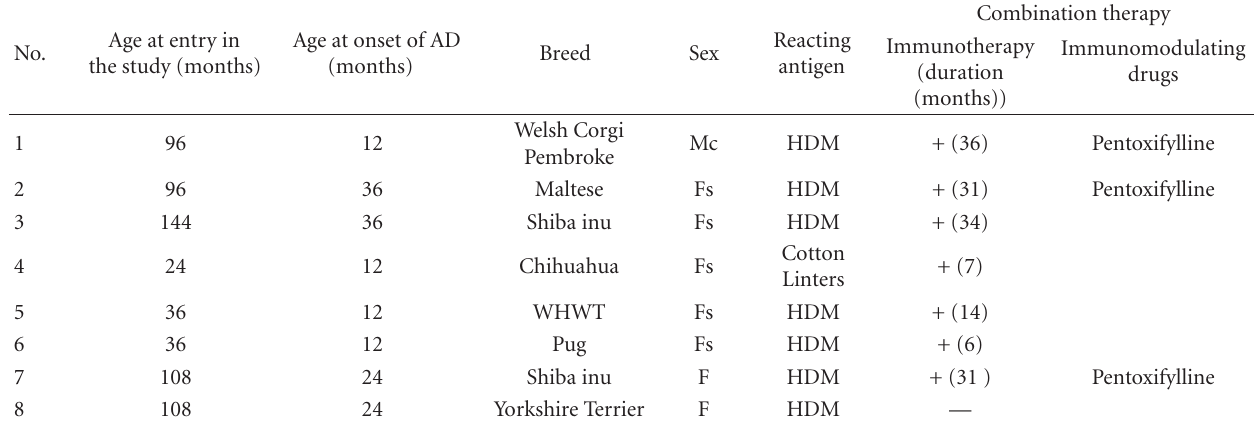
Table 1: Characteristics of dogs at enrollment in the